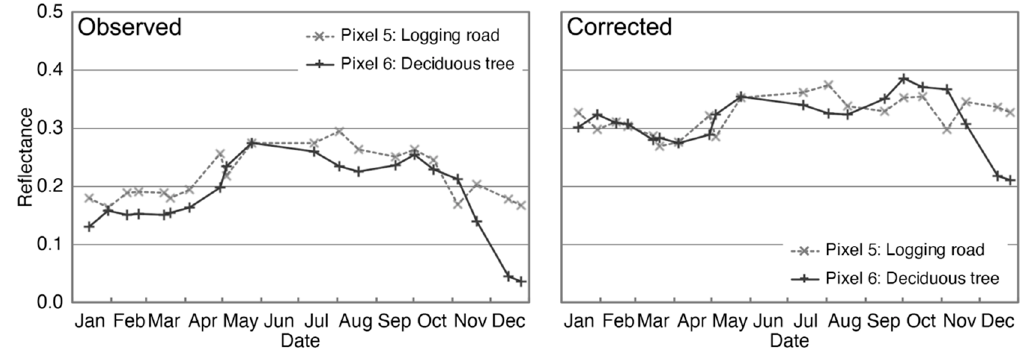
Figure 15. Time series of observed ( left ) and corrected ( right ) reflectance in the NIR band for the sample pixels over deciduous vegetation. Pixel locations are shown in DSM in Figure 5b.